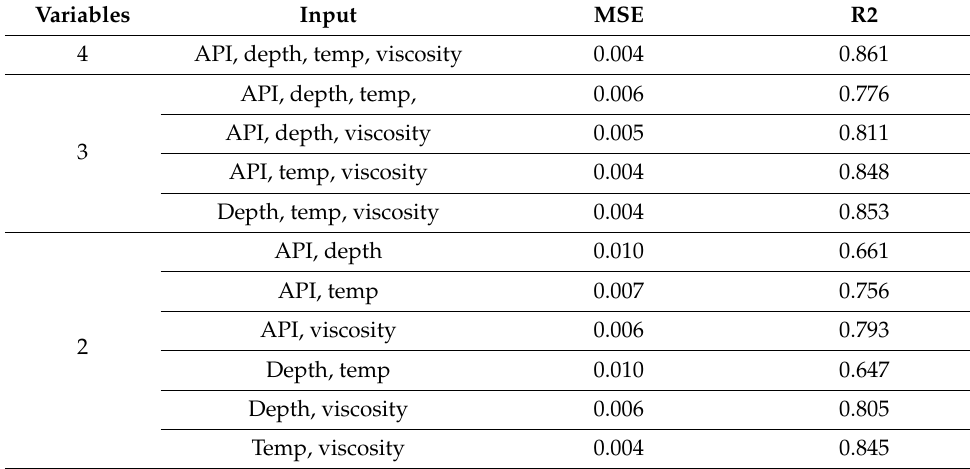
Table 2. Prediction error and effectiveness for the prediction of FVF across various input scenarios. Models were run to test model effectiveness for different input variable combinations to train the model. MSE = Mean Square Error; R2 = R-squared, or the coefficient of